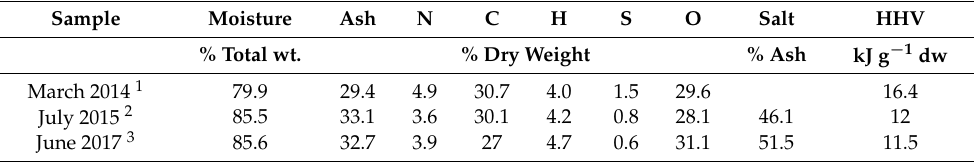
Table 7. Ultimate and proximate analysis of unwashed S. muticum collected from the Kent coast [26,36] and the current